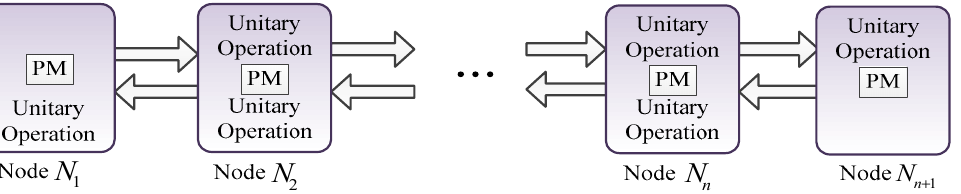
Figure 8. Hop-by-hop qubit transmission.